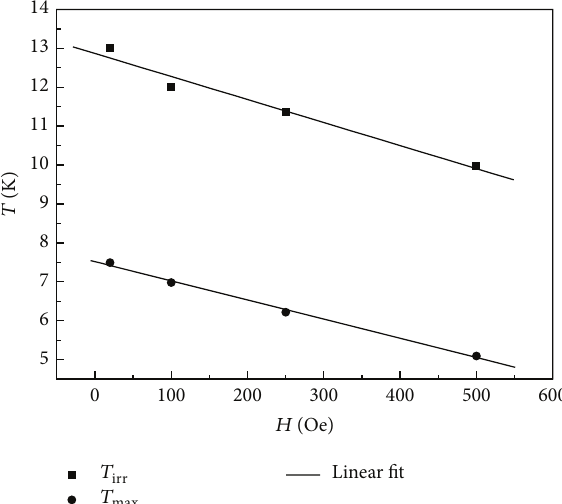
Figure 8: 𝜇 versus 𝑇 for the compound (insert: plot of 𝑑𝜇 eff versus 𝑇 ).